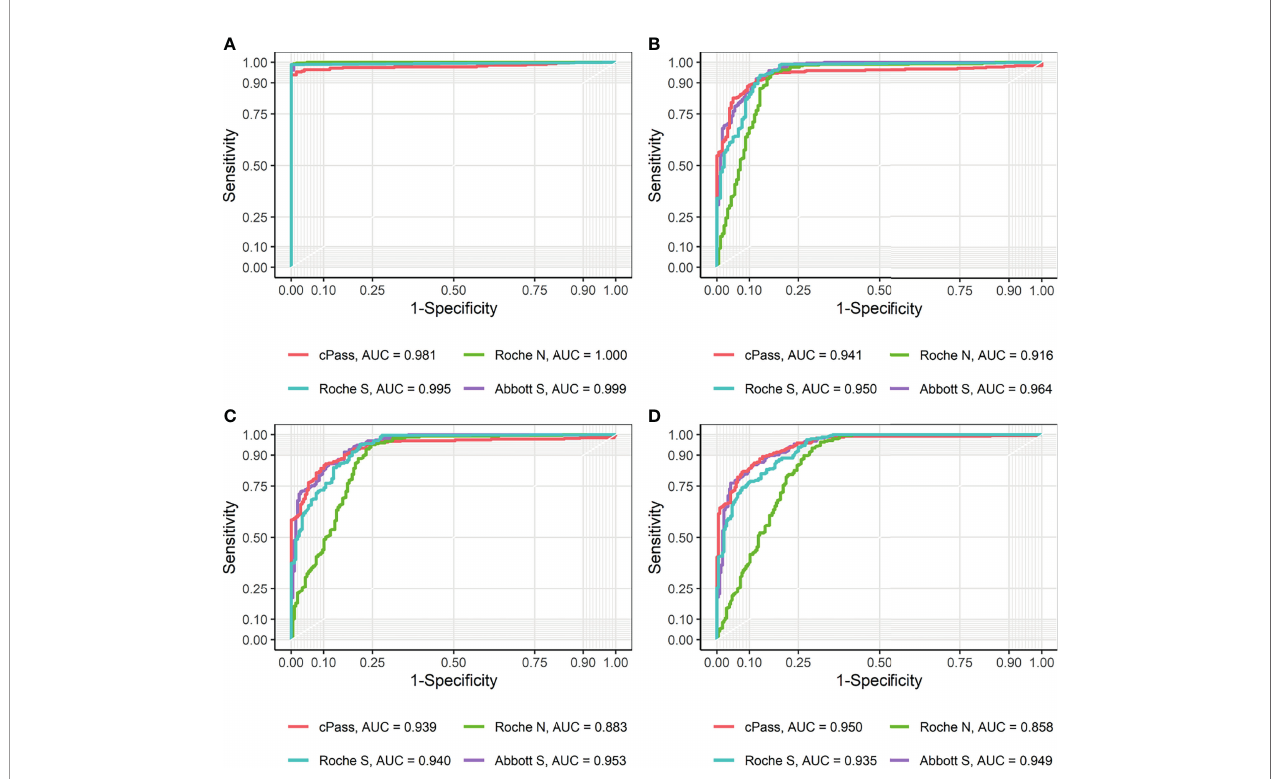
FIGURE 1 | Receiver operating characteristic (ROC) curves and area under curve (AUC) for each method (A) using positive and negative controls and (B – D) compared to PRNT ND 50 of (B) ≥ 20, (C) ≥ 40, and (D) ≥ 80,